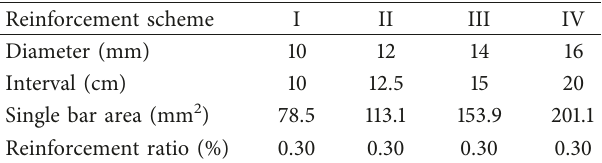
Figure 13: Crack development process and crack width in the abutment. Table 5: Evaluated crack-control reinforcement schemes. Reinforcement scheme